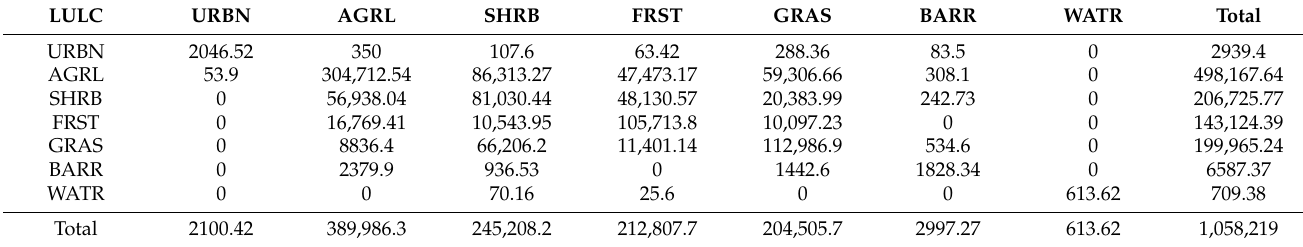
Table 5. LULC change matrix between the years 2001 and 2016